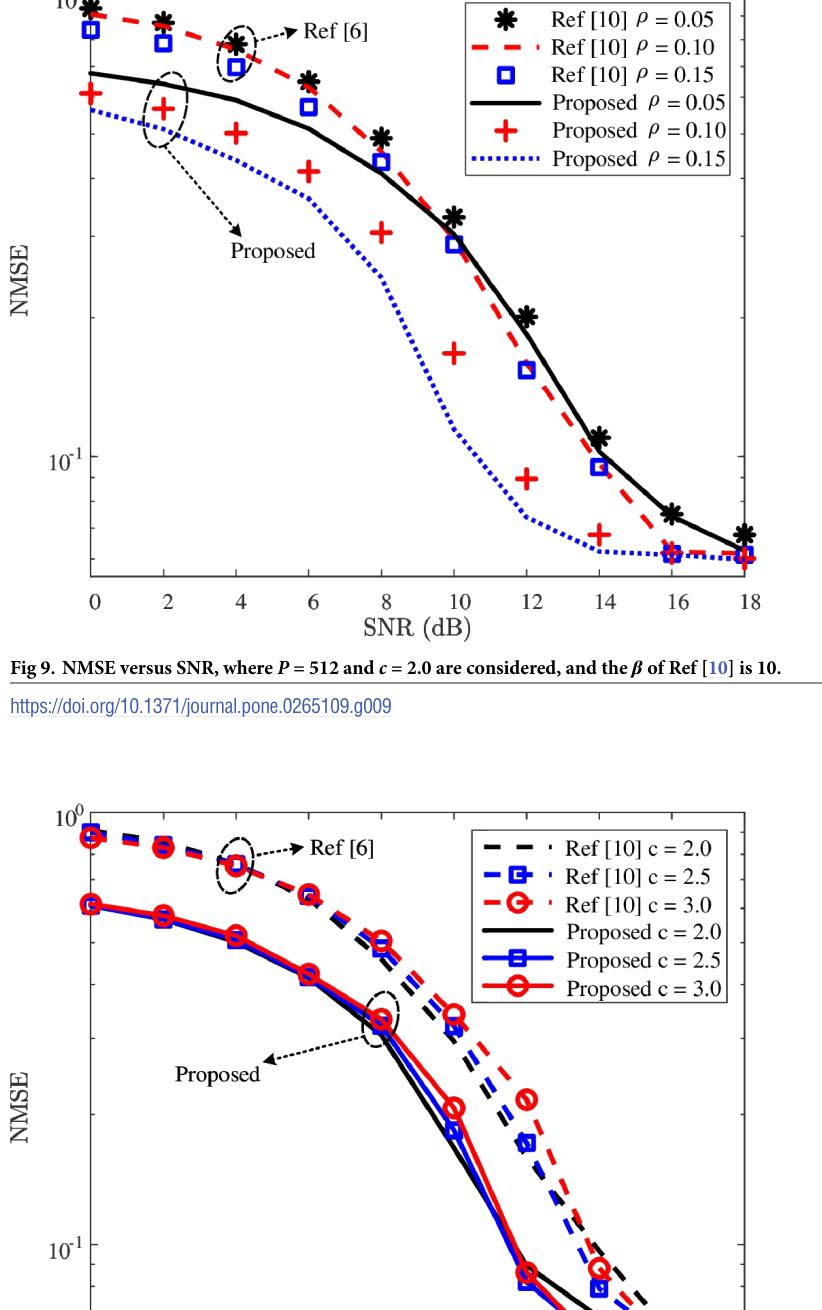
PLOS ONE | https://doi.org/10.1371/journal.pone.0265109 March 10,